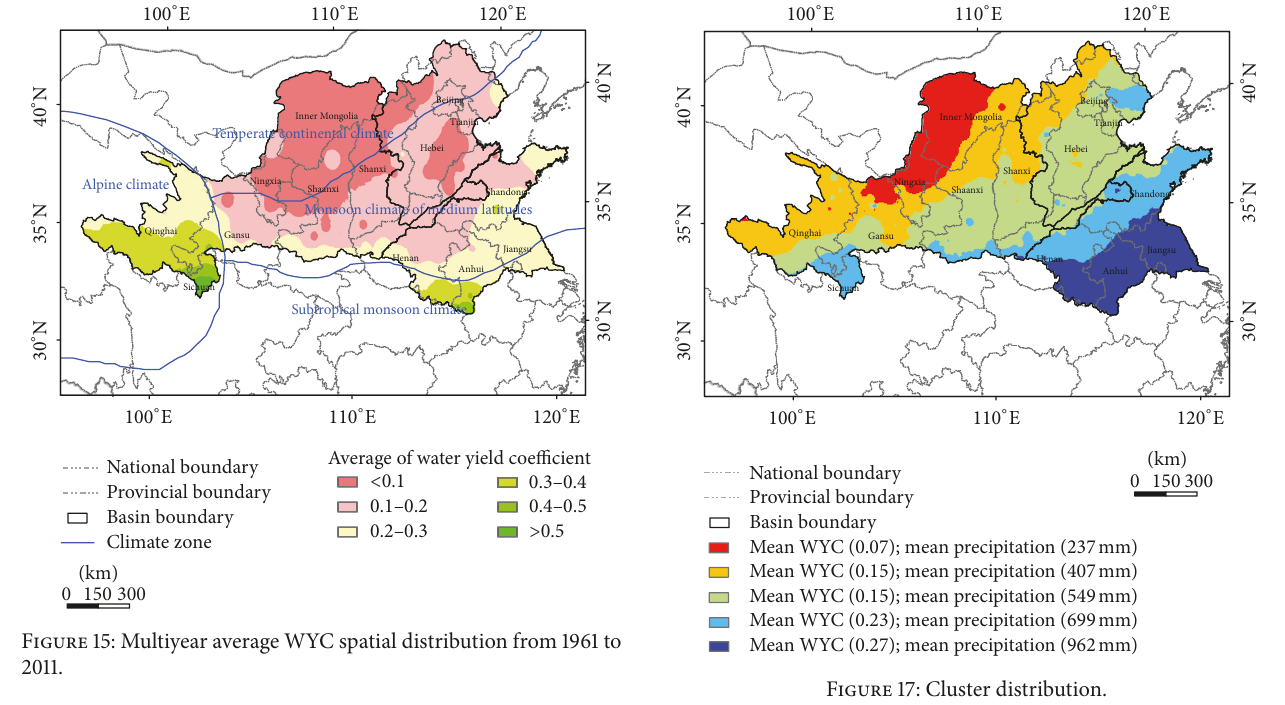
Figure 17: Cluster distribution.